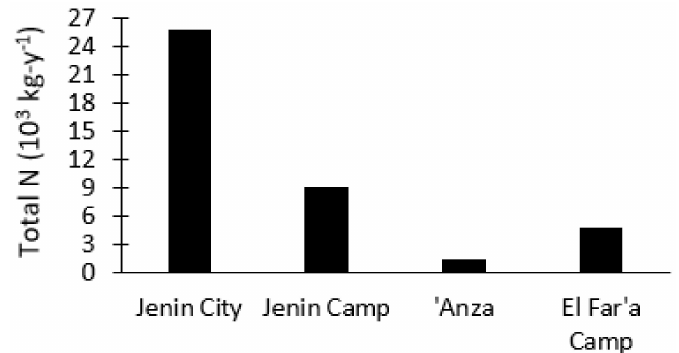
Figure 6. The annual nitrogen amounts due to the leakage from sewage